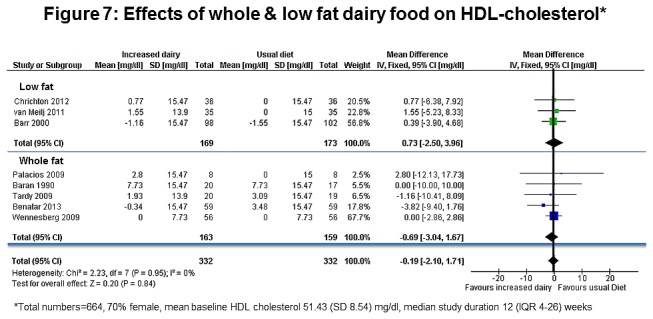
Effects of whole & low fat dairy food on HDL-cholesterol.